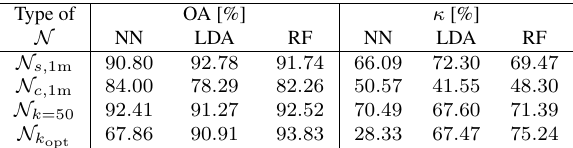
Table 1. Classification results obtained for Oakland-3C when us- ing the original point cloud, four different neighborhood types